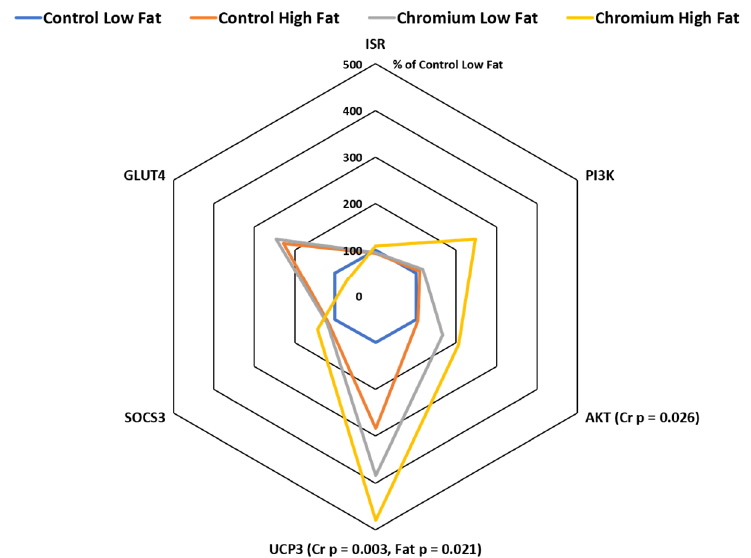
Figure 3. Phosphatidylinositol 3 kinase (PI3K), protein kinase B (AKT), uncoupling protein 3 (UCP3), suppressor of cytokine signaling 3 (SOCS3), glucose transporter 4 (GLUT4) and insulin receptor (IRS) mRNA expression in subcutaneous adipose tissue from gilts fed with nCrPic with or without a high-fat diet. All gene expression data were analysed as the threshold cycle (cT) relative to that of β -actin ( ∆ CT) and assessed for main and interactive e ff ects of dietary fat and nCrPic by ANOVA. A di ff erence in ∆ CT of − 1.0 is associated with a doubling (200%) and + 1.0 a halving (50%) of expression and for ease of presentation data are presented as % relative to expression in tissue from gilts fed the control diet without supplemental fat or nCrPic. This method of presentation prevents the presentation of the error term.